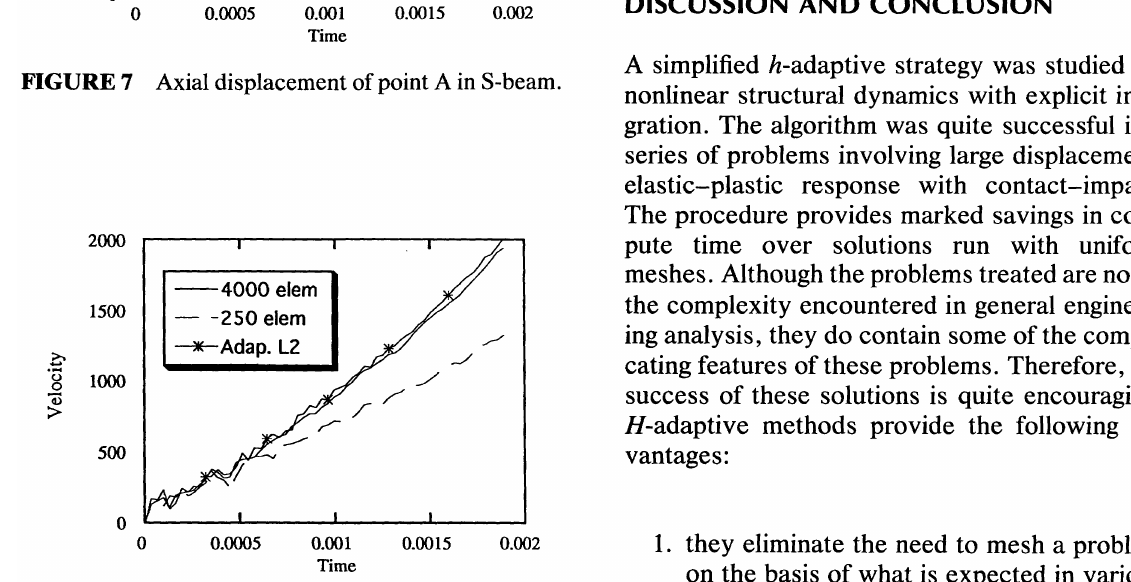
FIGURE 8 Axial velocity of point A in